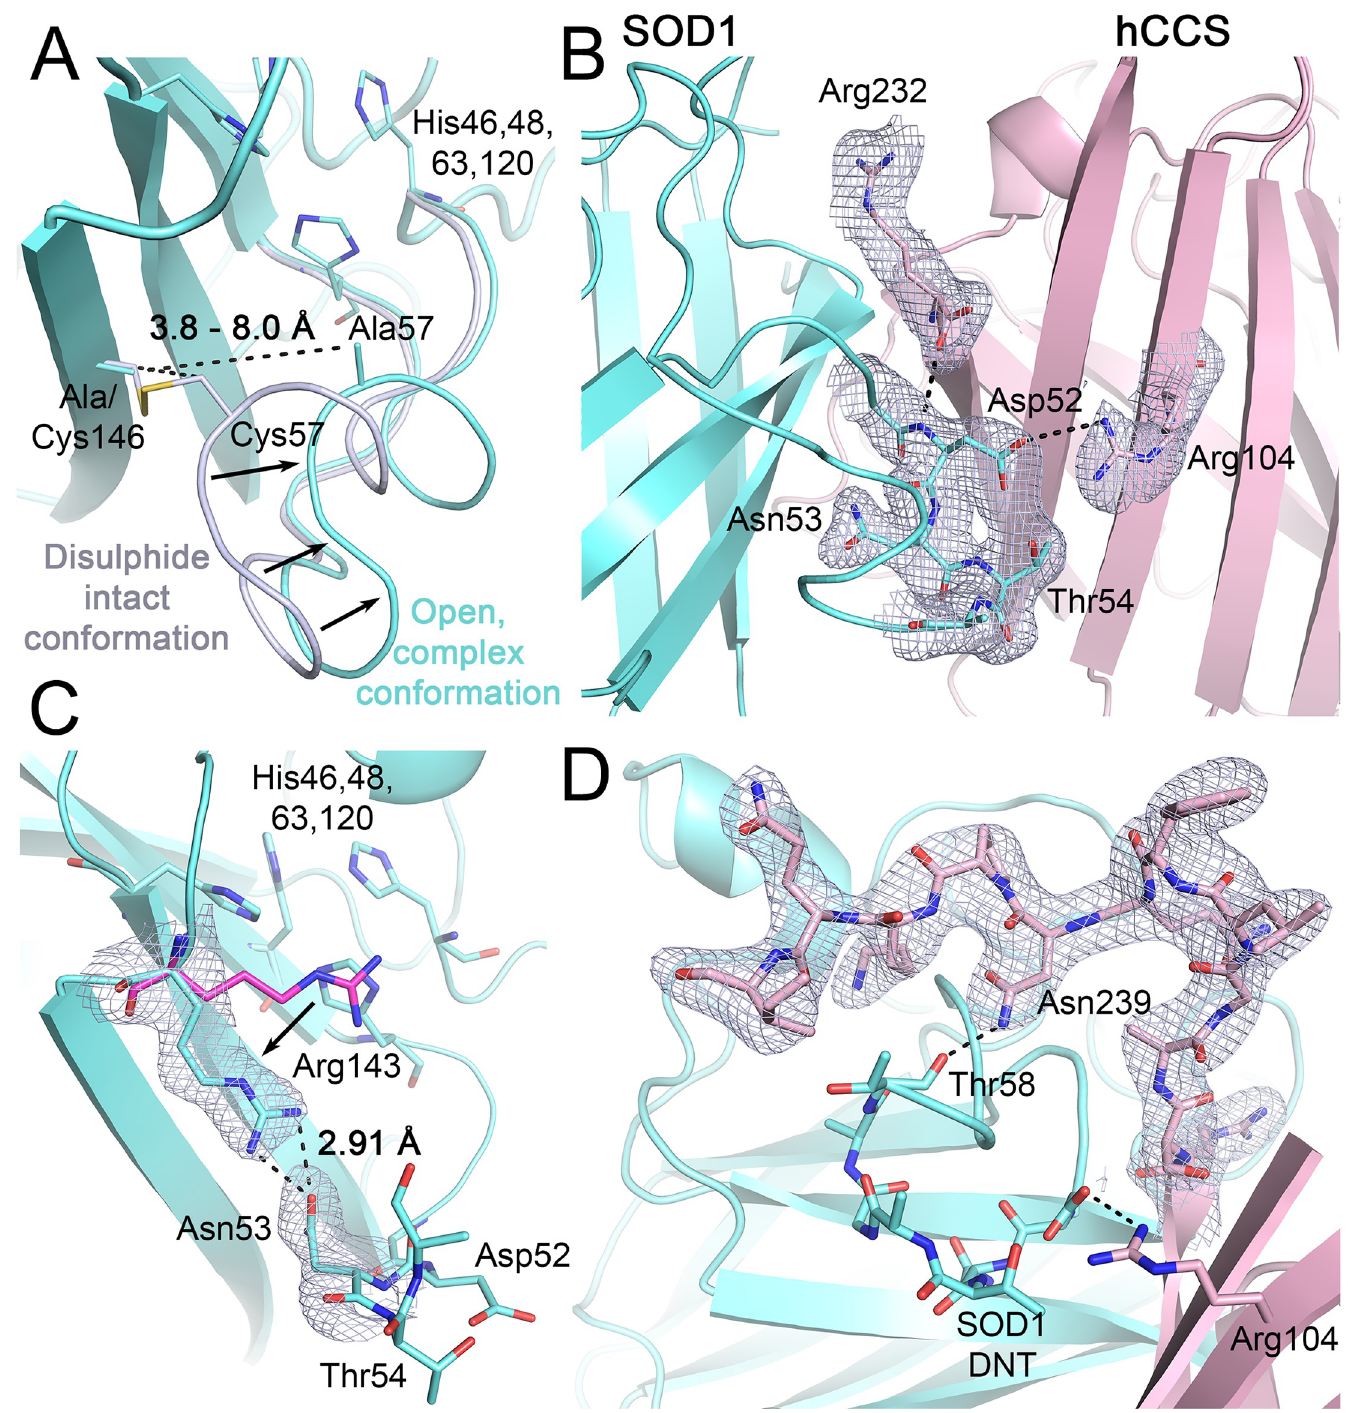
Fig 3. hSOD1 induced-fit complexation. ( A ) Complexation with hCCS forces the hSOD1 disulphide sub-loop to adopt an open conformation separating the amino acids involved in disulphide formation. ( B ) Interactions across the heterodimer interface stabilise the hSOD1 disulphide sub-loop. ( C ) The hSOD1 Arg143 side chain interleaved between the β -barrel and disulphide sub-loop, hydrogen bonded with the DNT motif Asn53, and compared with the conformation found in homodimeric hSOD1 (magenta). ( D ) hCCS domain III is recruited to the hSOD1 disulphide sub-loop by a restrictive domain I position and hydrogen bonding between hCCS C- terminal Asn239 and hSOD1 Thr58. This brings the functional hCCS CXC motif into the vicinity of hSOD1 Cys57. 2Fo-Fc electron density maps are contoured at the 1 σ level. hSOD1 is shown in cyan, hCCS in pink. CXC, Cys-Xxx-Cys; GDNT, Gly51-Asp52-Asn53-Thr54; hCCS, human copper chaperone for SOD1; hSOD1, human copper chaperone for SOD1; SOD1, superoxide dismutase-1.